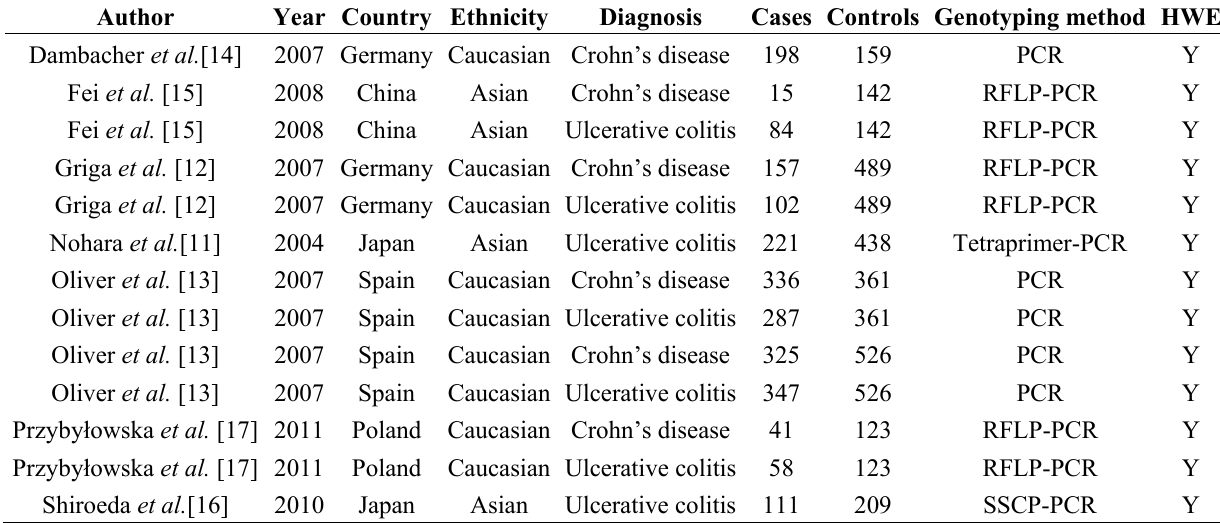
Table 1. Characteristics of included studies.